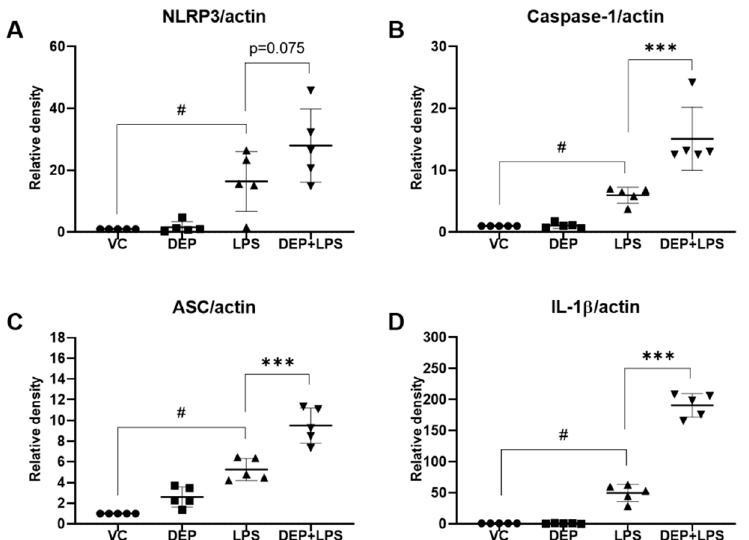
Figure 7. Protein levels of ( A ) NLRP3, ( B ) caspase-1, ( C ) ASC, and ( D ) IL-1 β in the lung tissue of mice in the vehicle control (VC), DEP, LPS, and DEP pre-exposed and LPS-instilled (DEP+LPS) groups. Data represent means ± SD (n = 5 per group). # p < 0.05 vs. VC, *** p < 0.001 vs. LPS group.